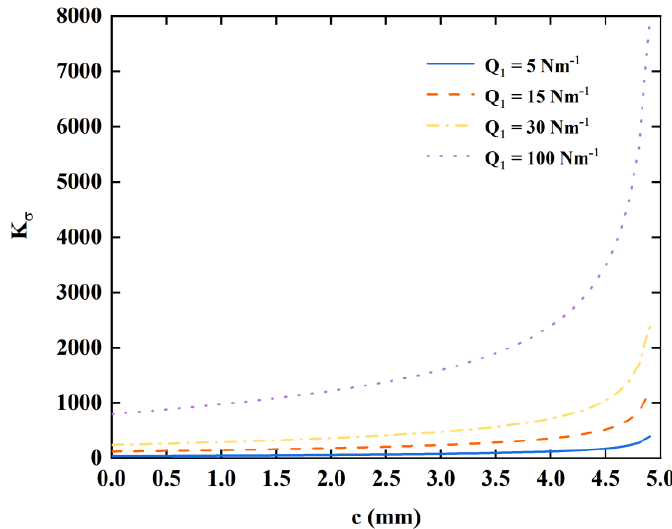
Figure 2. Influence of linear force 𝑄 1 on the phonon field stress intensity factor 𝐾 𝜎 .